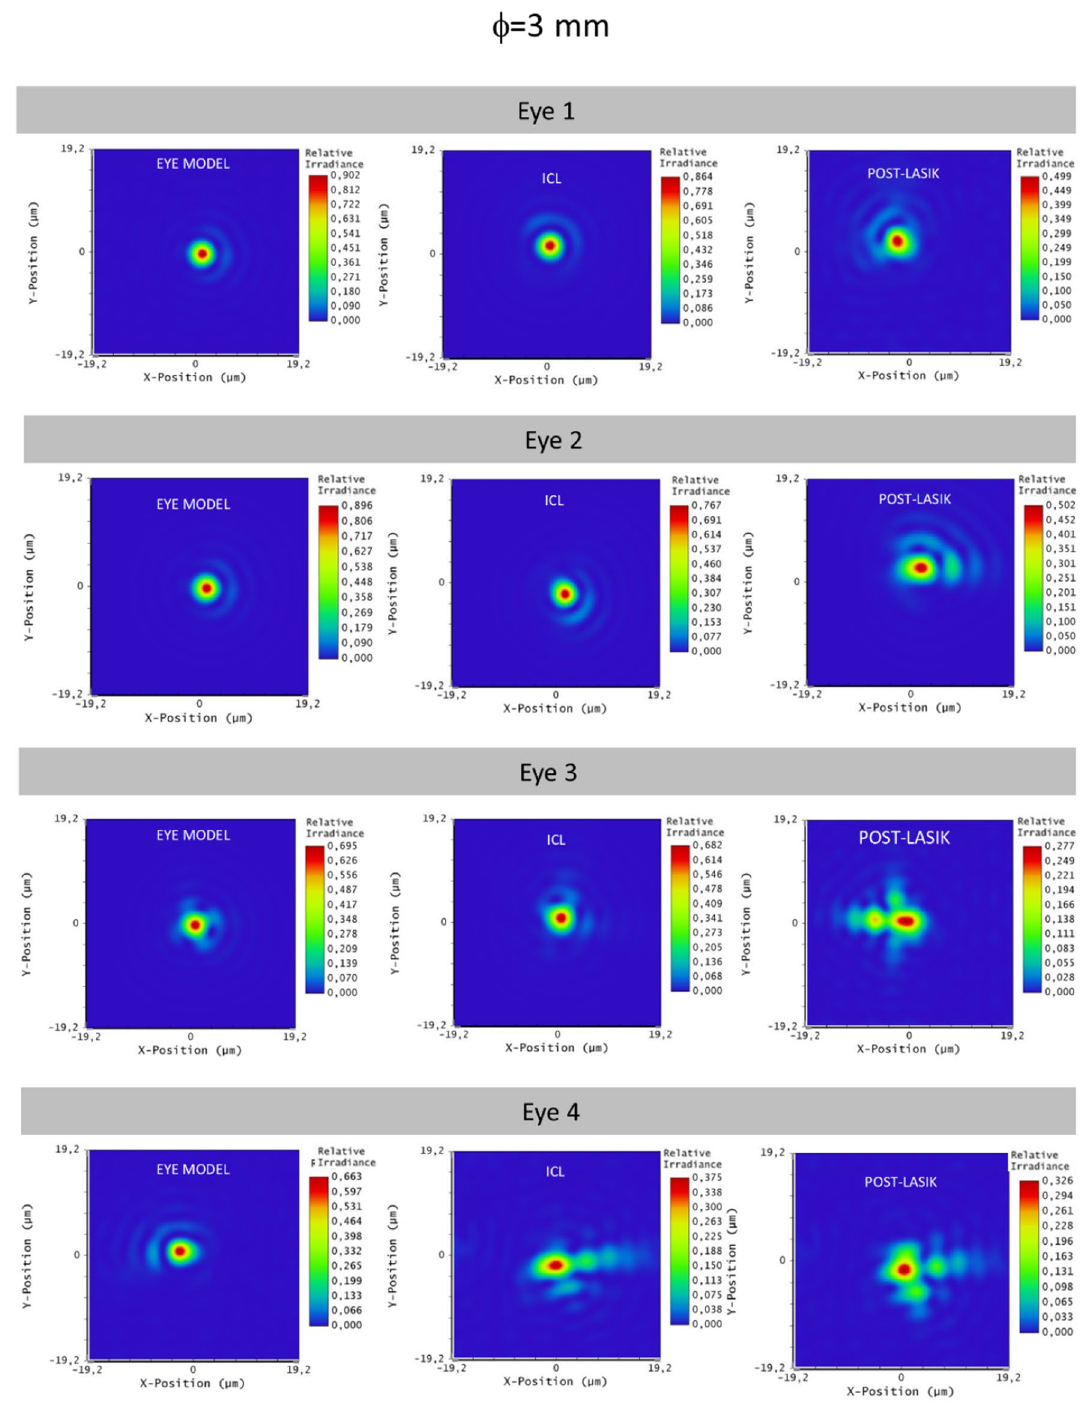
Figure 3. Point Spread Function (PSF) of the three eye models (eye model, ICL model and post-LASIK model) for the pupil size of 3